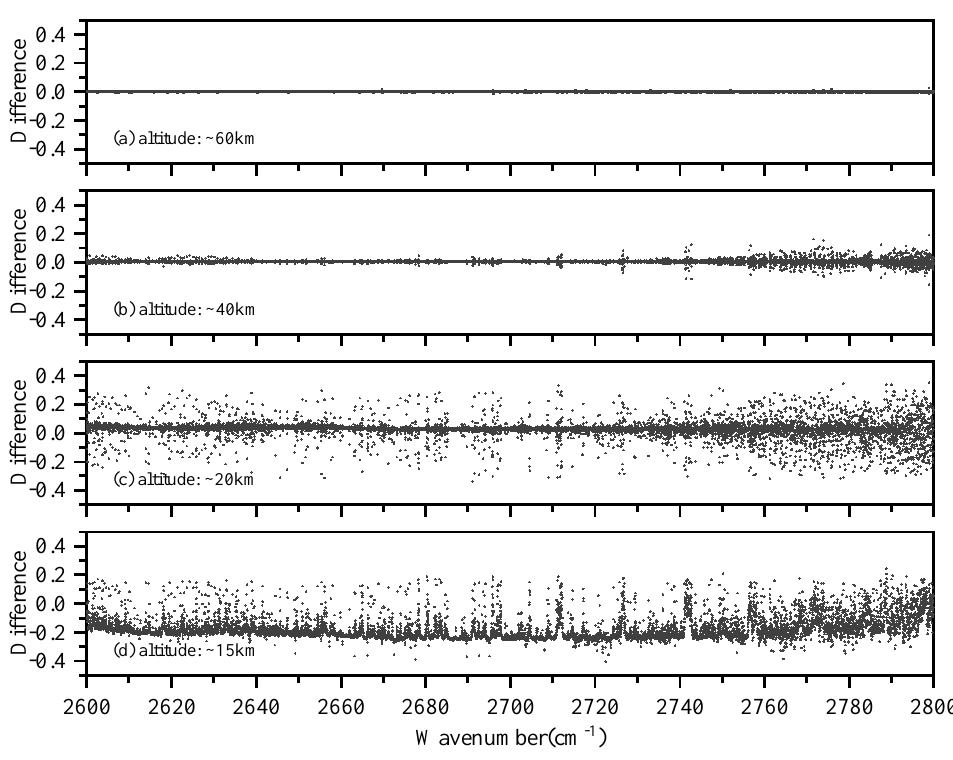
Figure A6. The transmittance differences between AIUS measurements and simulations in